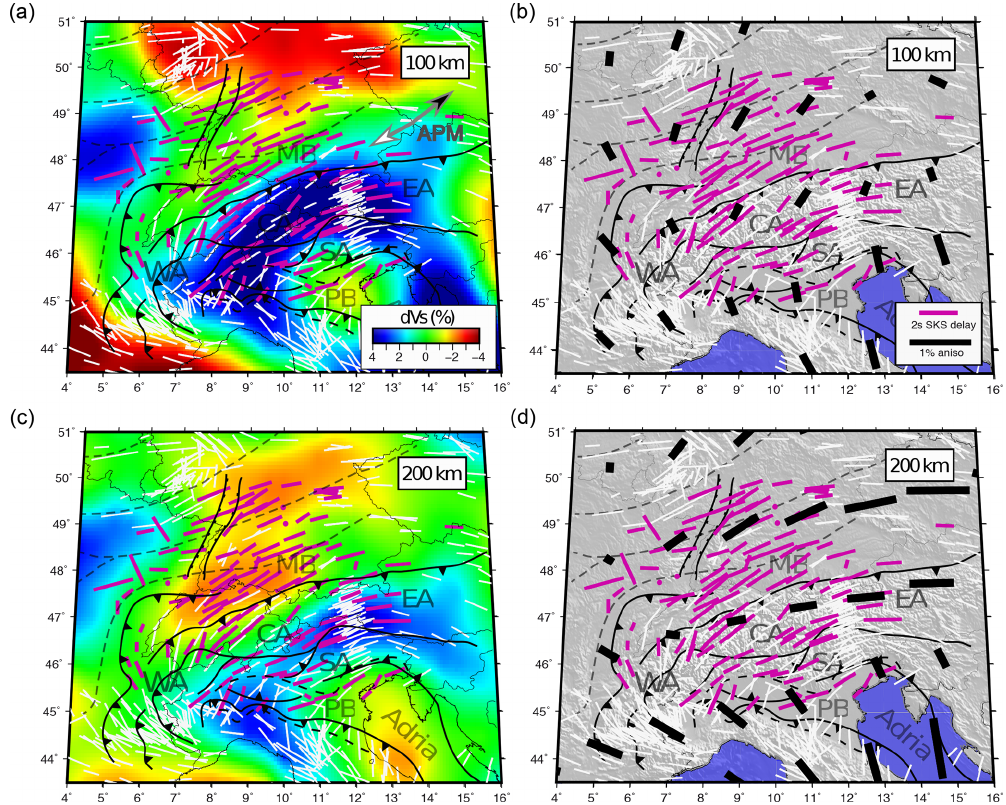
Figure 7. (a, c) The comparison of SKS results with the seismic tomography model by Zhu et al. (2015) at 100km (a) and 200km (c) . Magenta lines are SKS fast axes and delay times obtained in this study, while white bars are previous measurements (Salimbeni et al., 2008, 2013; Barruol et al., 2011; Kummerow et al., 2006; Bokelmann et al., 2013; Qorbani et al., 2016). In the 100km slice map, also absolute plate motion (APM) is reported: the black arrowhead represents the EU plate motion in no net rotation (NNR) system for GSRMv2.1, ITRF2014[2016], and HS3-NUVEL1A; the white arrowhead is again the EU plate motion direction in the “Hot Spot” reference system valid for HS3-Nuvel1 (Kreemer et al., 2014; Altamimi et al., 2016; Gripp and Gordon, 2002). (b, d) The comparison of SKS results from this study and previous measurements with azimuthal anisotropy percentages (black bars) estimated by Zhu et al. (2015) at 100km (b) and 200km (d) , respectively.